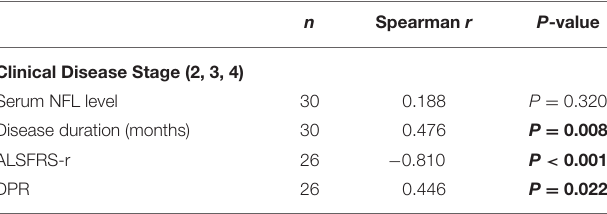
TABLE 3 | The correlation between the disease stage and clinical parameters of patients with